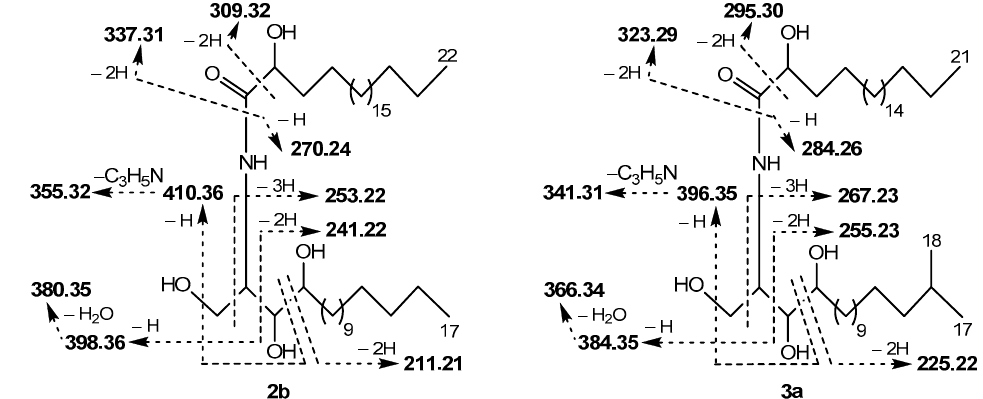
Figure 2. Fragment ions detected in the (–)ESI-MS/MS spectrum of [M − H] − ion ( m / z 640.59) of ceramides 2b (as well as 1b ) and 3a (as well as 4a ). In addition, [M − H − H 2 O] − ( m / z 622.58), [M − H ‒ H 2 CO] − ( m / z 610.57), [M − H − H 2 CO − 2H] − ( m / z 608.56), [M − H − 2H 2 O] − ( m / z 604.57), and [M − H − H 2 O − H 2 CO] − ( m / z 574.56) ions were observed in the spectrum. This MS/MS interpretation is consistent with the one described by Hsu [22].